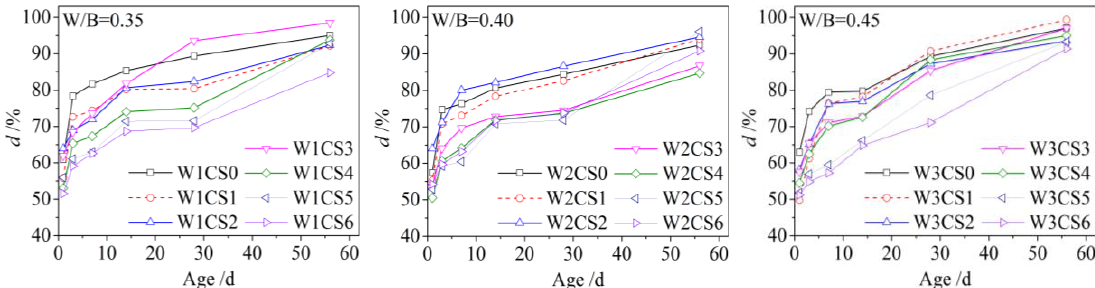
Figure 4. Hydration degree of the sample at a different age.